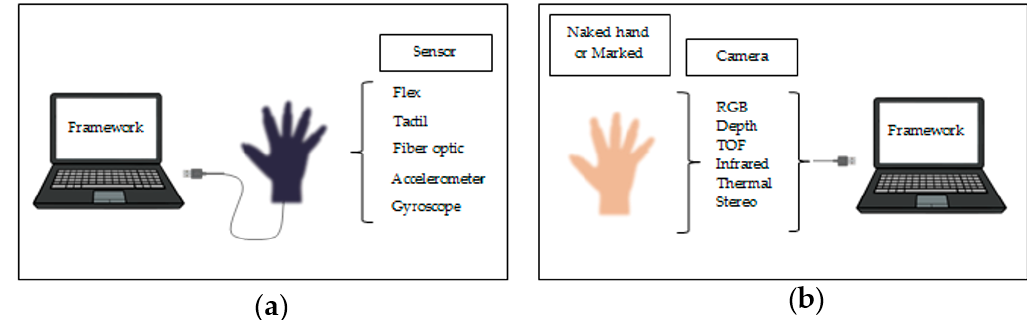
Figure 1. Different techniques for hand gestures. ( a ) Glove-based attached sensor either connected to the computer or portable; ( b ) computer vision–based camera using a marked glove or just a naked hand.